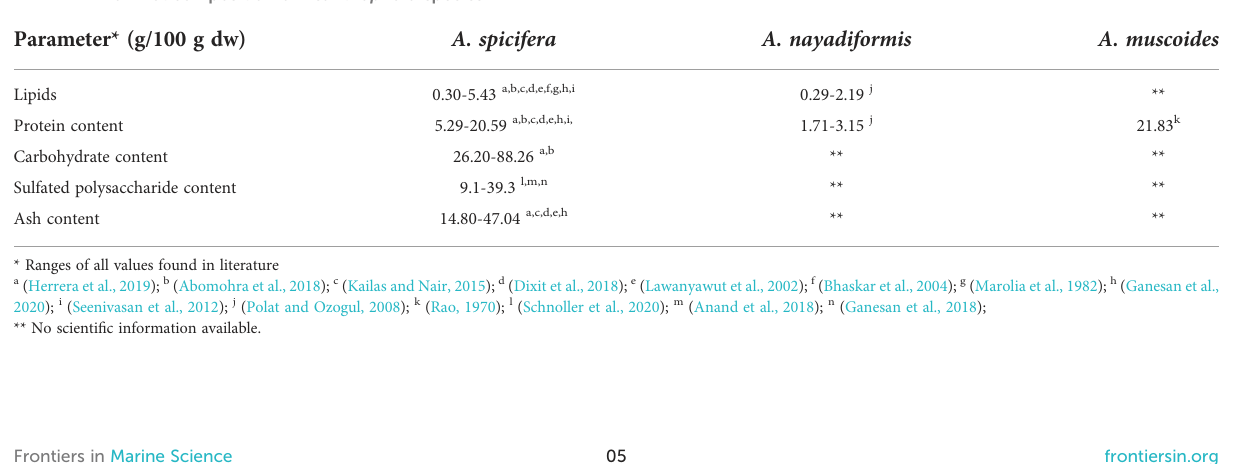
TABLE 2 Proximal composition of Acanthophora